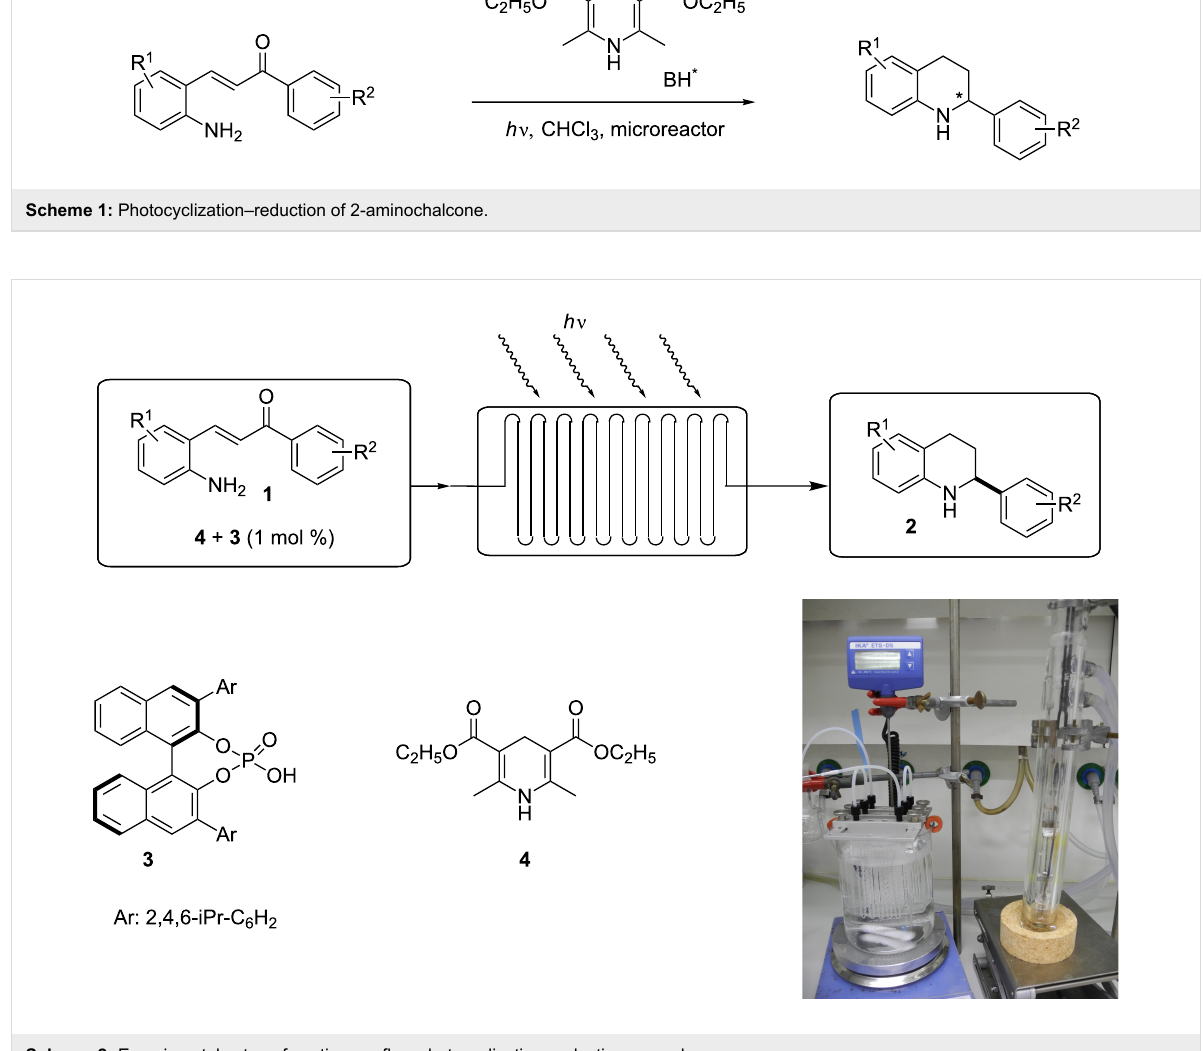
Scheme 2: Experimental setup of continuous-flow photocyclization–reduction